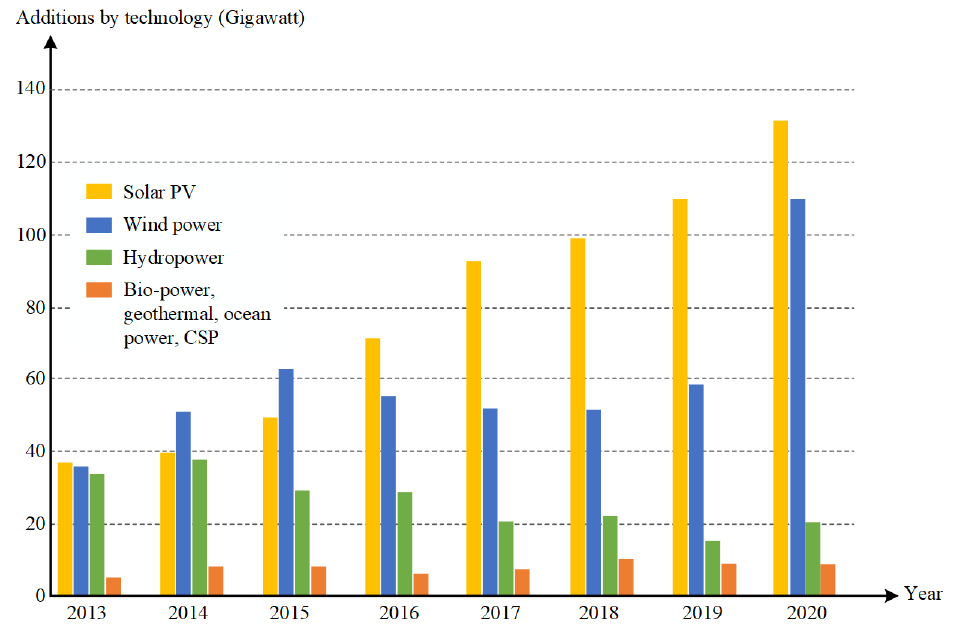
Figure 1. Global annual addition of RESs, indicating solar energy has the highest rising potential, topping the list of annual capacity installations for four consecutive years